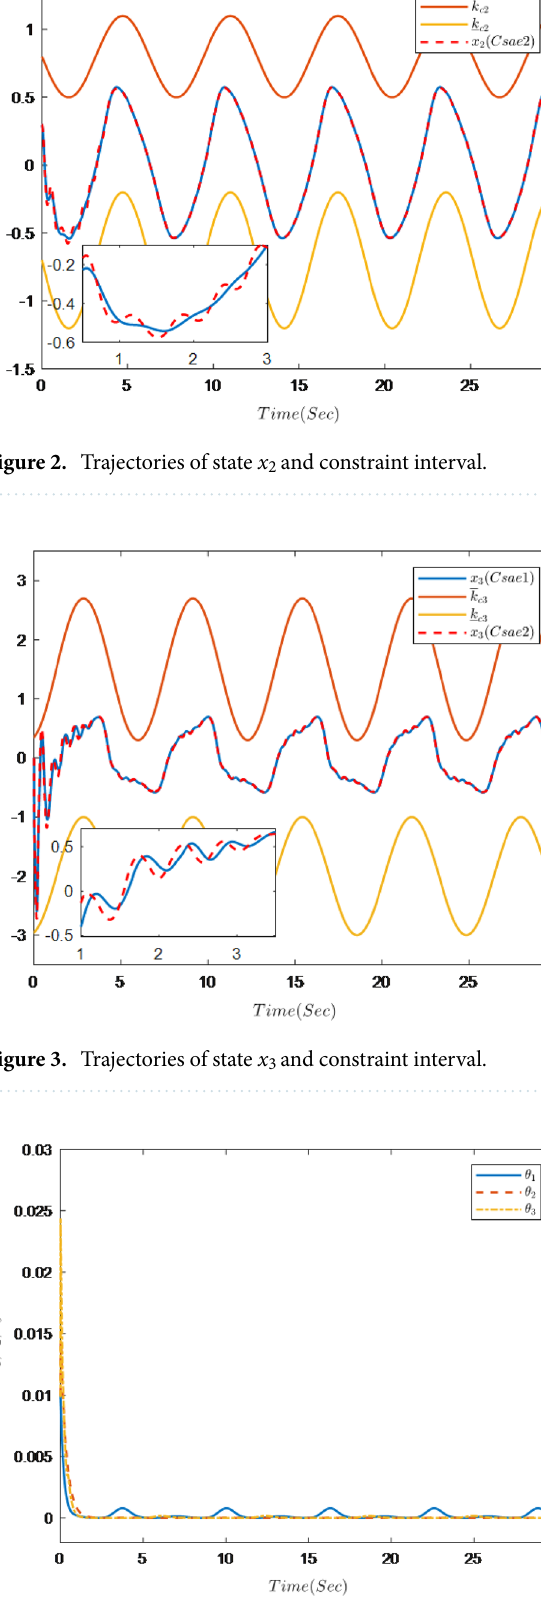
Figure 4. Trajectories of adaptive law θ 1 θ 2 θ 3